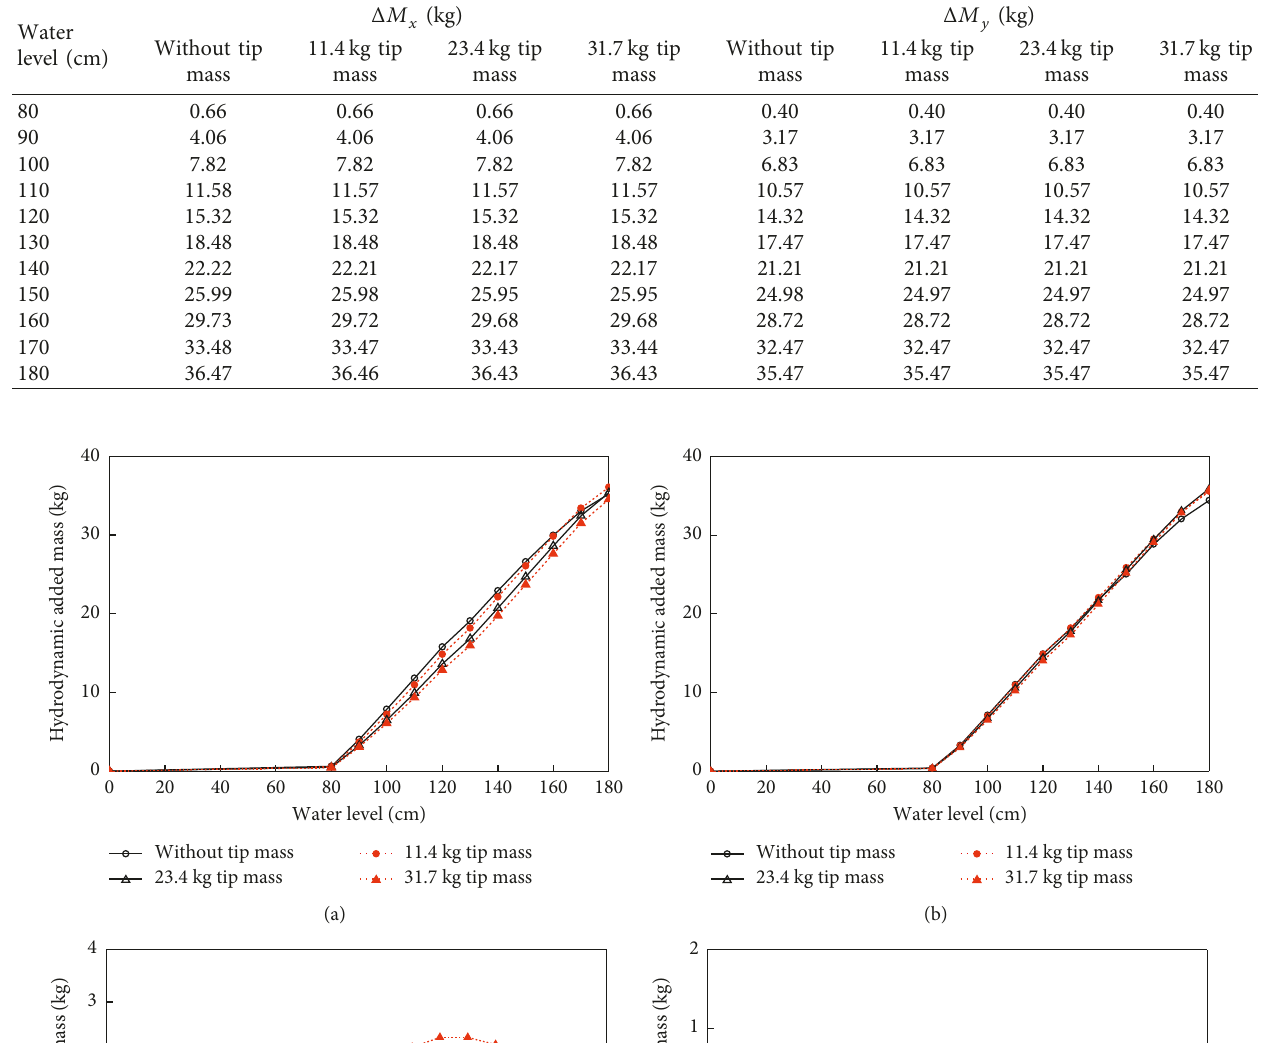
Table 4: HAM along the x -axis and y -axis for the four tip masses in case